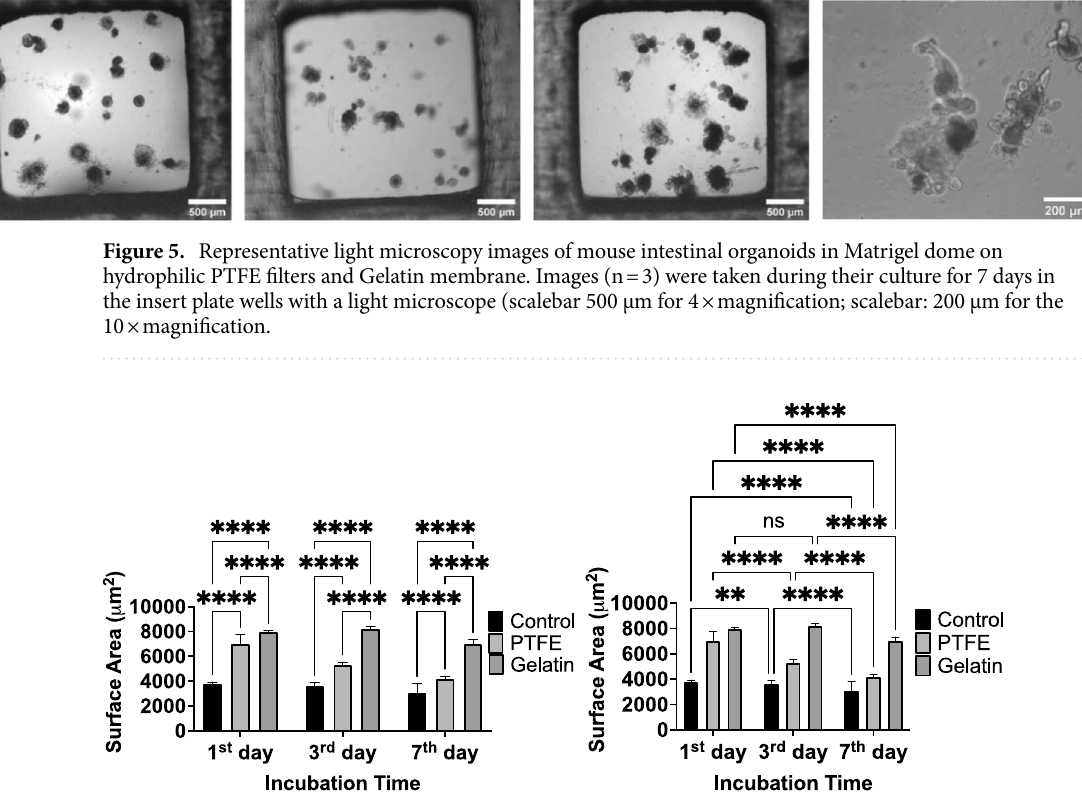
Figure 6. The surface area of organoids during 7 days of culture. Left Comparison of size changes of organoids depending on the surface substrate. Right Comparison of size changes of organoids during the incubation time. Error bars indicate mean S.D. statistical significance: ns = P > 0.05, **P < 0.01, ****P <